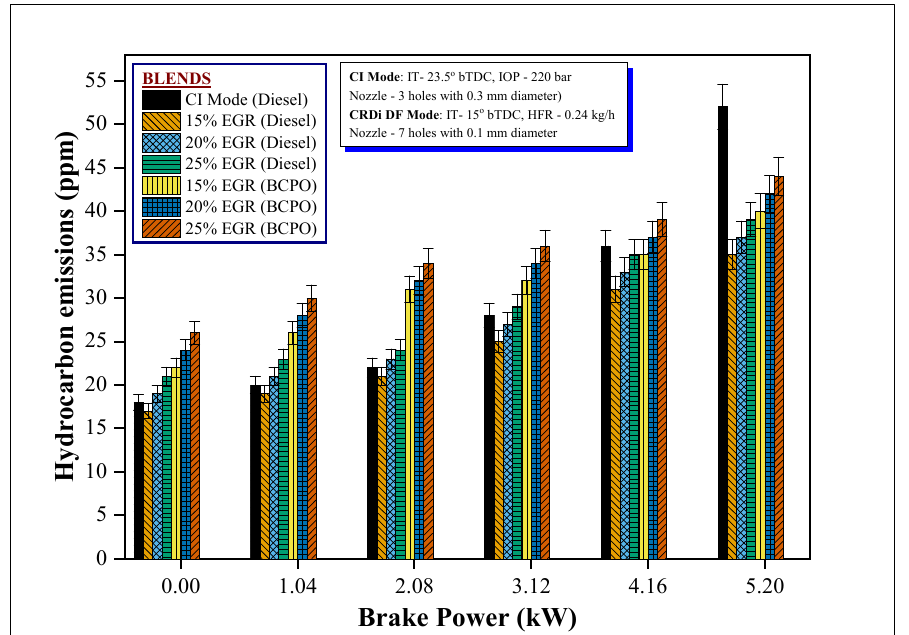
Figure 14. EGR and BP influence on CRDi engine HC emissions.